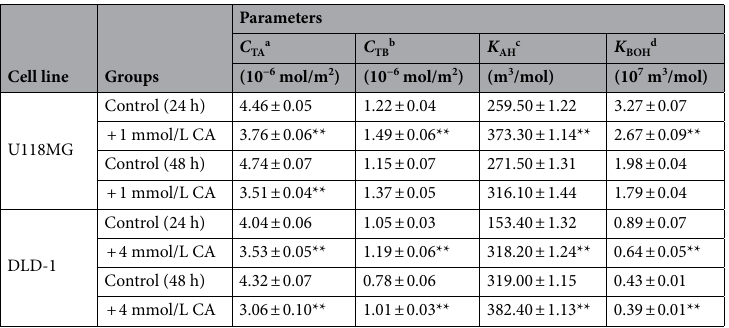
Table 1. Effect of caffeic acid on the acidic and basic functional groups concentrations and associations constants with H + and OH − ions of U118MG glioblastoma and DLD-1 colorectal adenocarcinoma cell membranes. a Concentration of functional acidic groups. b Concentration of functional basic groups. c Association constant with hydrogen ions. d Association constant with hydroxyl ions. Statistical difference in comparison to control. ** p <